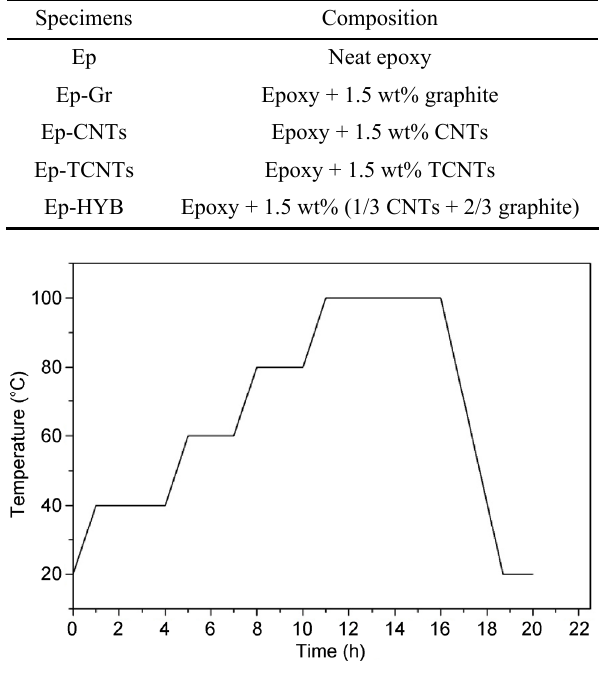
Fig. 1 Postcuring cycle of epoxy